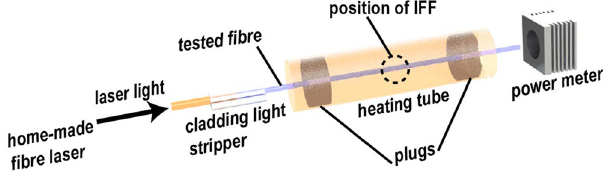
Figure 1. Experimental setup for triggering the